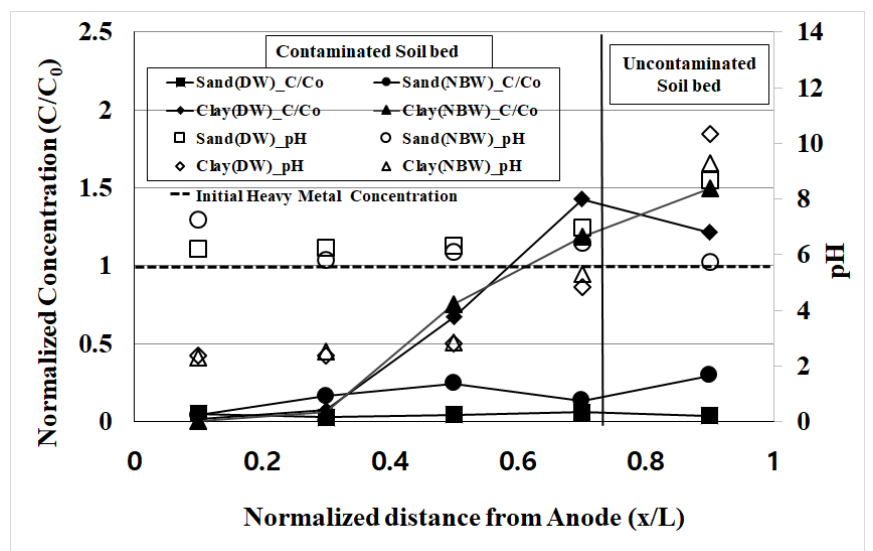
Figure 8. Cumulative flow.